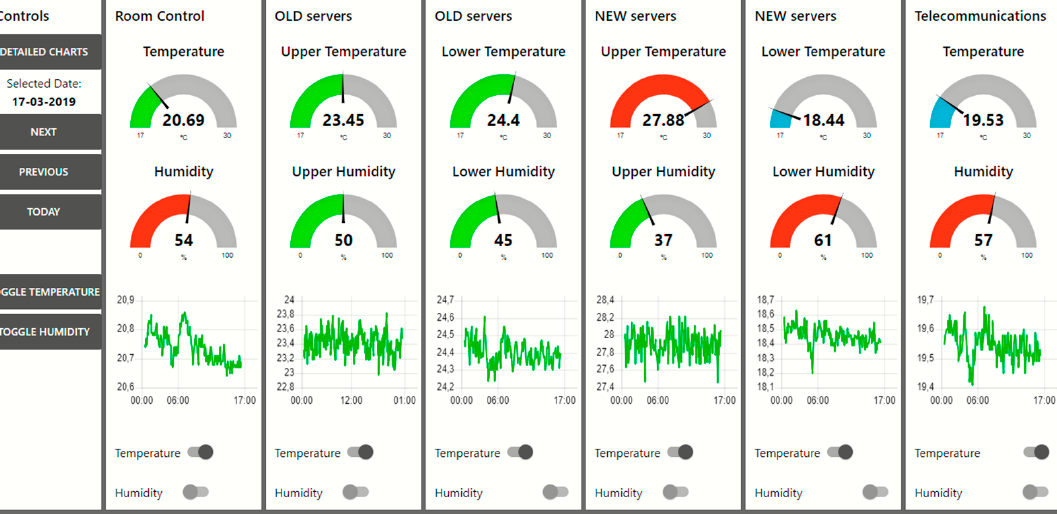
Figure 9. Dashboard main console displaying details about each sensor.